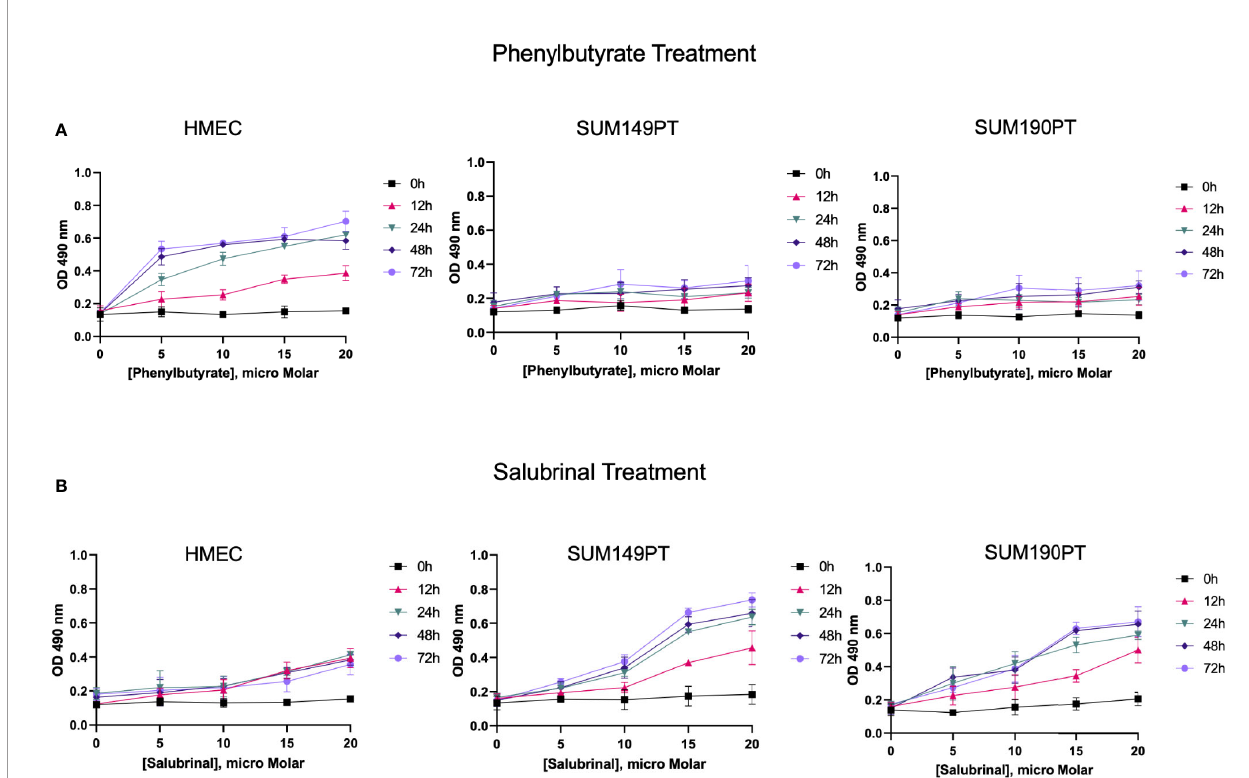
FIGURE 4 | IBC cell lines were chemosensitive to Saburinal treatment. (A) Effect of Phenylbutyrate treatment on cytotoxicity. HMEC, SUM149PT, and SUM190PT cells were untreated or treated with Phenylbutyrate at varying concentrations for different time periods, as indicated. Supernatants were collected from the cells to measure the amount of LDH released using spectrophotometry at 490 nm. Each point represents the average ± the standard deviation of three experiments. (B) Effect of Salubrinal treatment on cytotoxicity. HMEC, SUM149PT, and SUM190PT cells were untreated or treated with Salubrinal at varying concentrations for different time points, as indicated. Supernatants were collected from the cells to measure the amount of LDH released using spectrophotometry at 490 nm. Each point represents the average ± the standard deviation of three